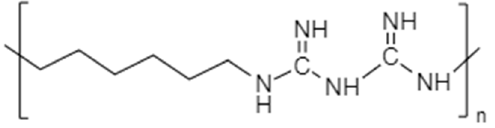
Figure 4. Molecular Structure of poly(hexamethylenebiguanide) (PHMB).